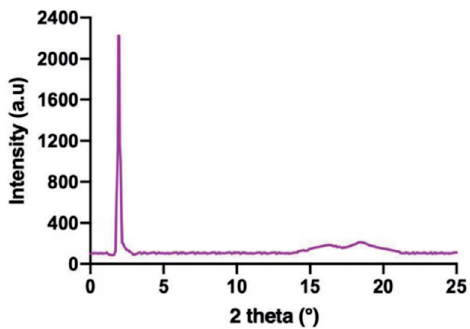
Figure 13. XRD diffractogram of compound 11c . Reprinted/adapted with permission from Ref. [47]; published by Royal Society of Chemistry, 2020.